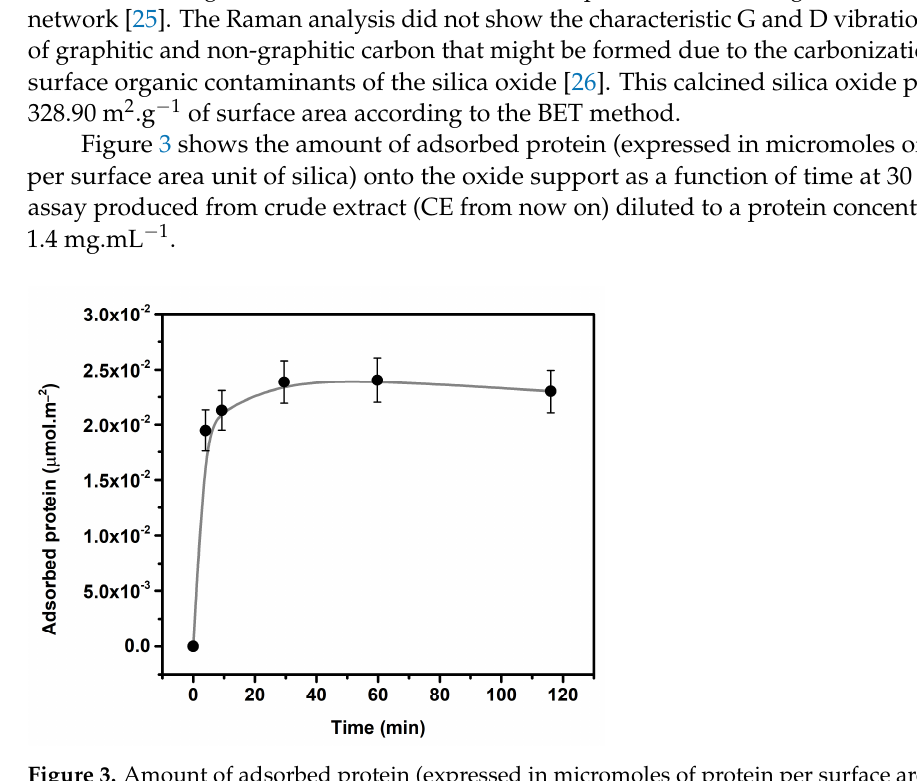
Figure 2. Raman spectra at room temperature of calcined Ns SiO 2 using excitation wavelengths at 405, 514 and 785 nm.